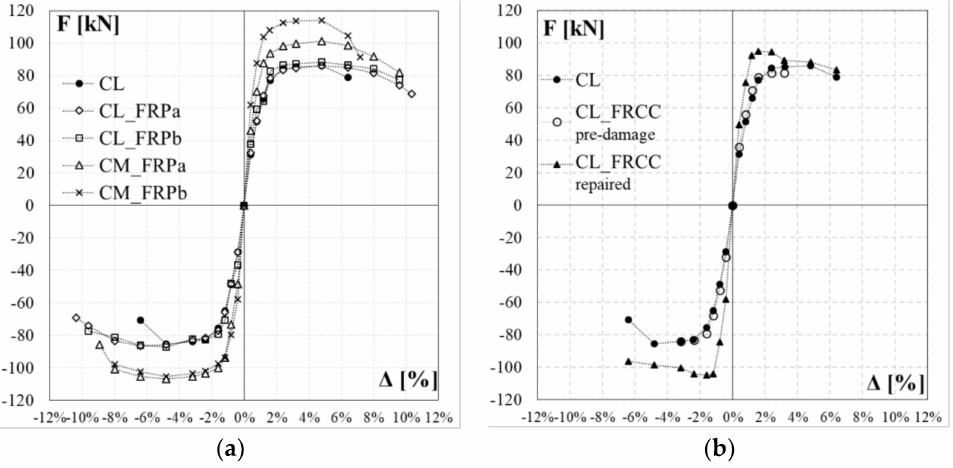
Figure 17. Envelope curves: comparison between control specimen and ( a ) CFRP strengthened columns; ( b ) pre-damaged and FRCC strengthened